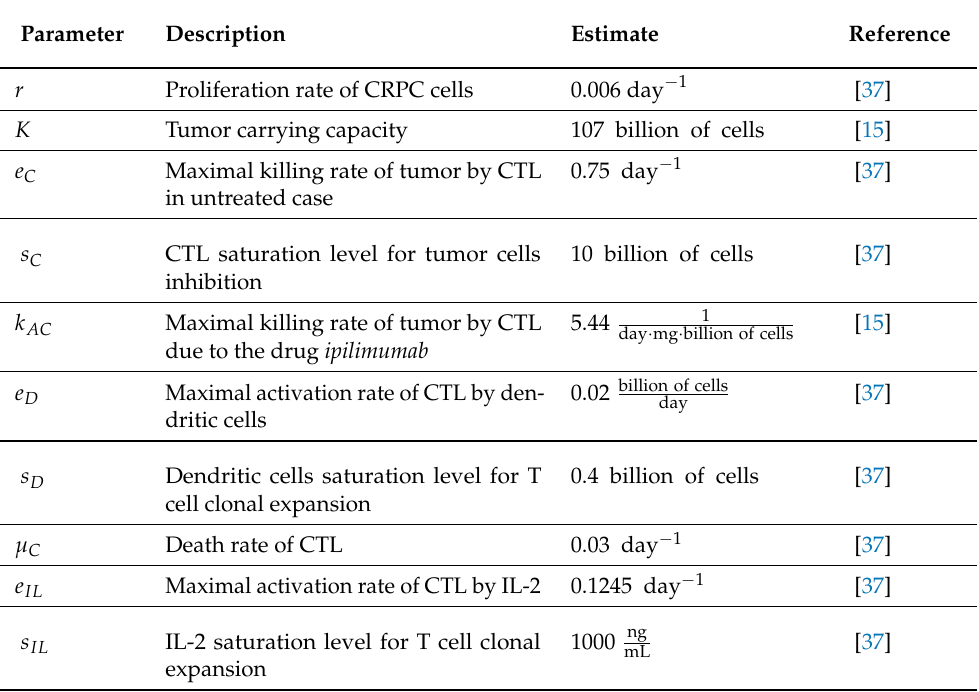
Maximal killing rate of tumor by